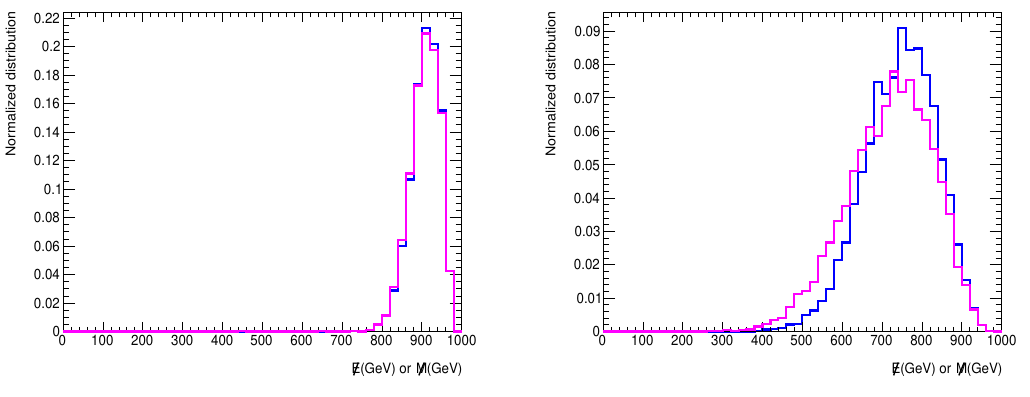
Figure 26. Comaparison between /E (blue) and /M (pink) distribution for Left: { ∆ m, m DM } = { 10 , 50 } GeV, Right: { ∆ m, m DM } = { 450 , 20 }